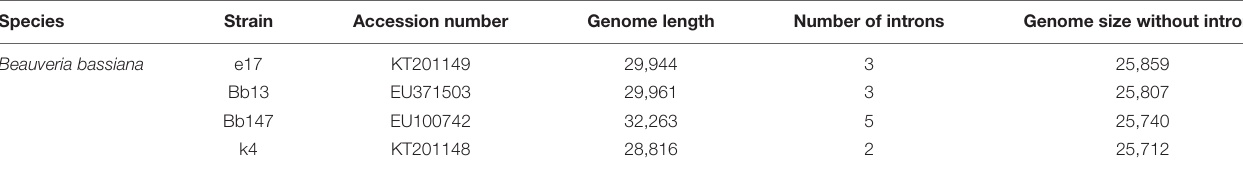
TABLE 3 | Characteristics of genomes of four different Beauveria bassiana strains. Species